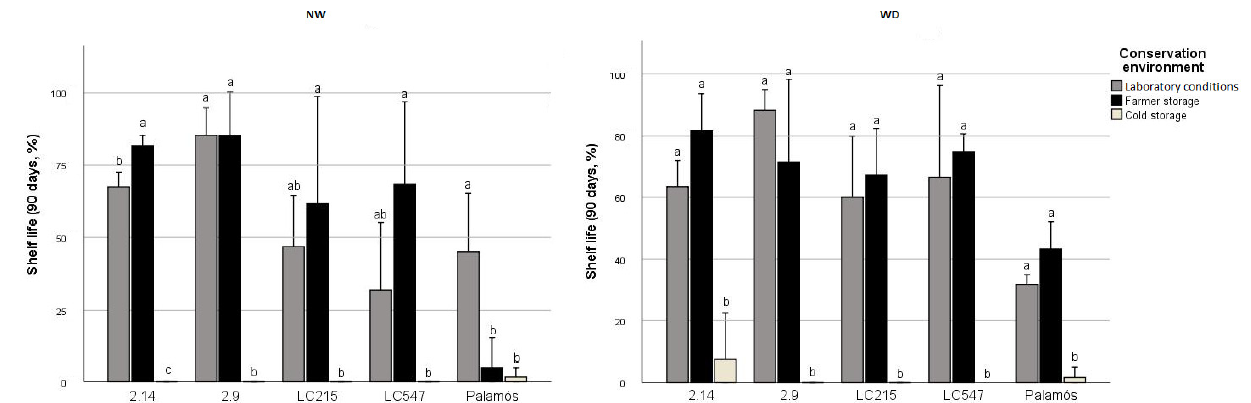
Figure 5. Effect of storage environment on the postharvest shelf life of 5 LSL genotypes after 90 postharvest days at each irrigation regime (NW, normal watering; WD, water deficit). Storage environments: laboratory conditions (24 ± 2 ◦ C; 62 ± 11% relative humidity), farmer storage facilities (ambient conditions), and cold room storage (8 ± 2 ◦ C, 95 ± 5% relative humidity). Columns represent mean values per genotype and conservation environment and error bars represent the standard error of the mean (SEM). Within each genotype, different letters indicate significant differences between storage conditions ( p < 0.05, Tukey multiple range tests). Genotypes: 2.9 and 2.14, Penjar breeding lines; LC215 (Penjar) and LC547 (Ramellet), LSL traditional lines; Palam ó s, Penjar modern hybrid; Pera Delta, processing variety.